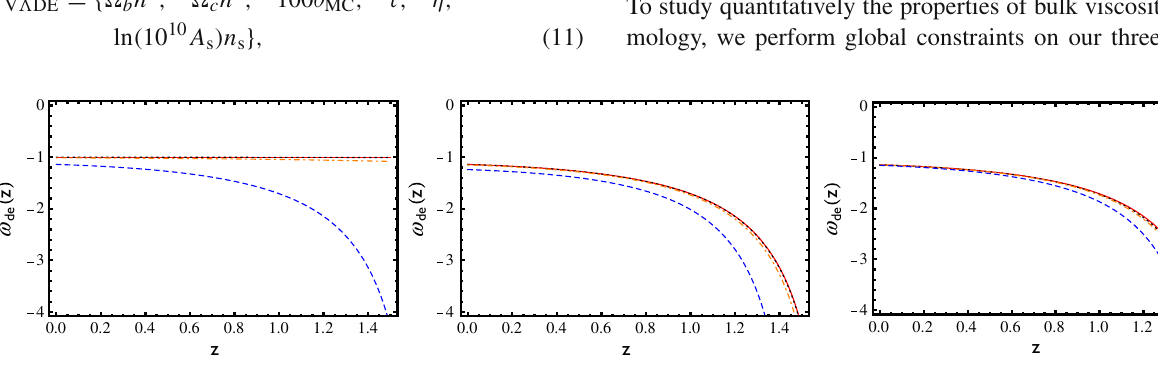
cases of ω = − 1, − 1.001, − 1.01 and − 1.1, respectively. Right panel The effects of the spatial curvature (cid:11) k on the effective EoS of VDE ω ( z ) in the VKDE model. Fixing η = 0 . 1, the solid (red), dotted de (black), dash-dotted (orange) and dashed (blue) lines correspond to the cases of (cid:11) k = 0 . 001, 0.005, 0.01 and 0.05, respectively. Here we have assumed (cid:11) m = 0 .